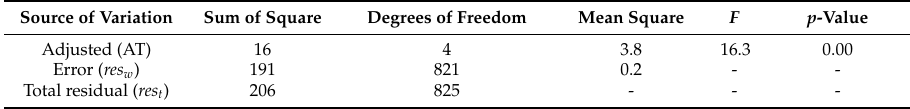
Table 10. Computation table for the cutting facilities based on sand casting